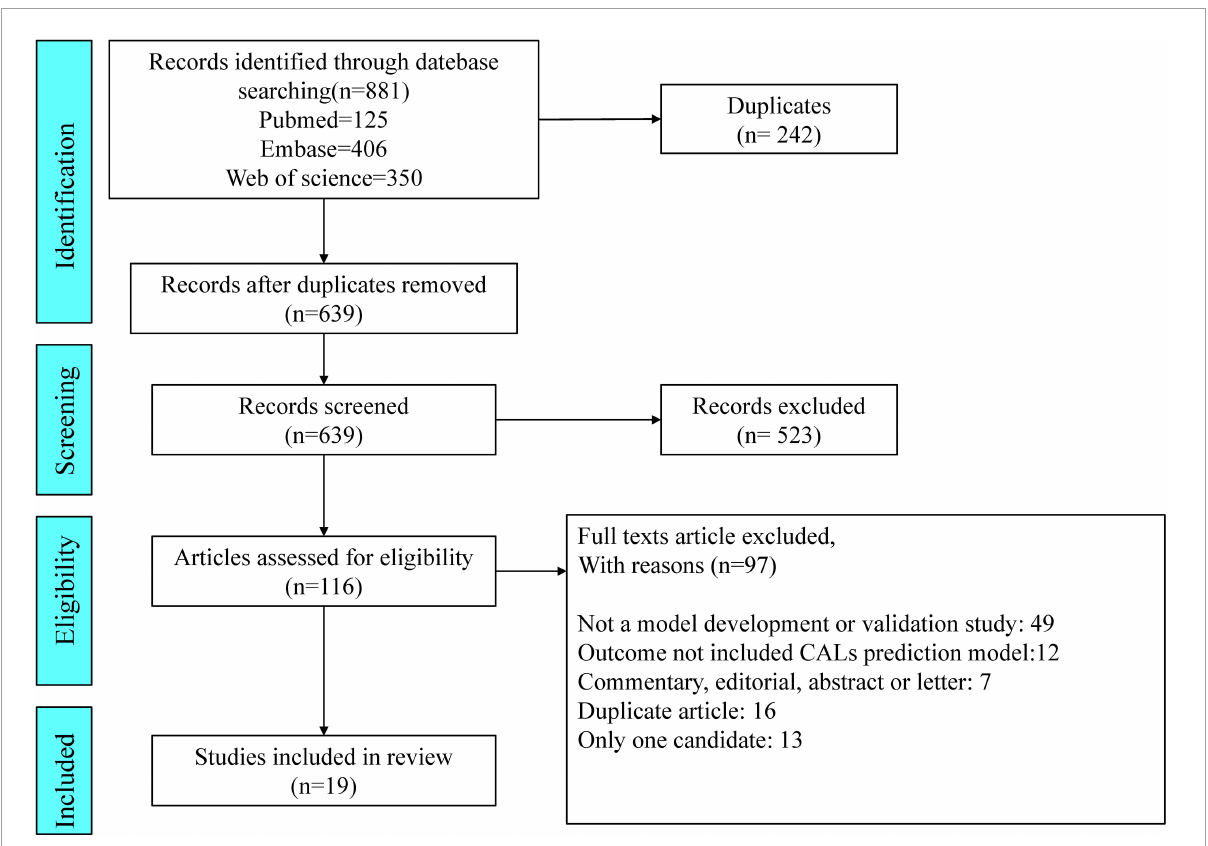
FIGURE1 Preferred Reporting Items for Systematic Reviews and Meta-analyses (PRISMA) flowchart of the study inclusions and exclusions.